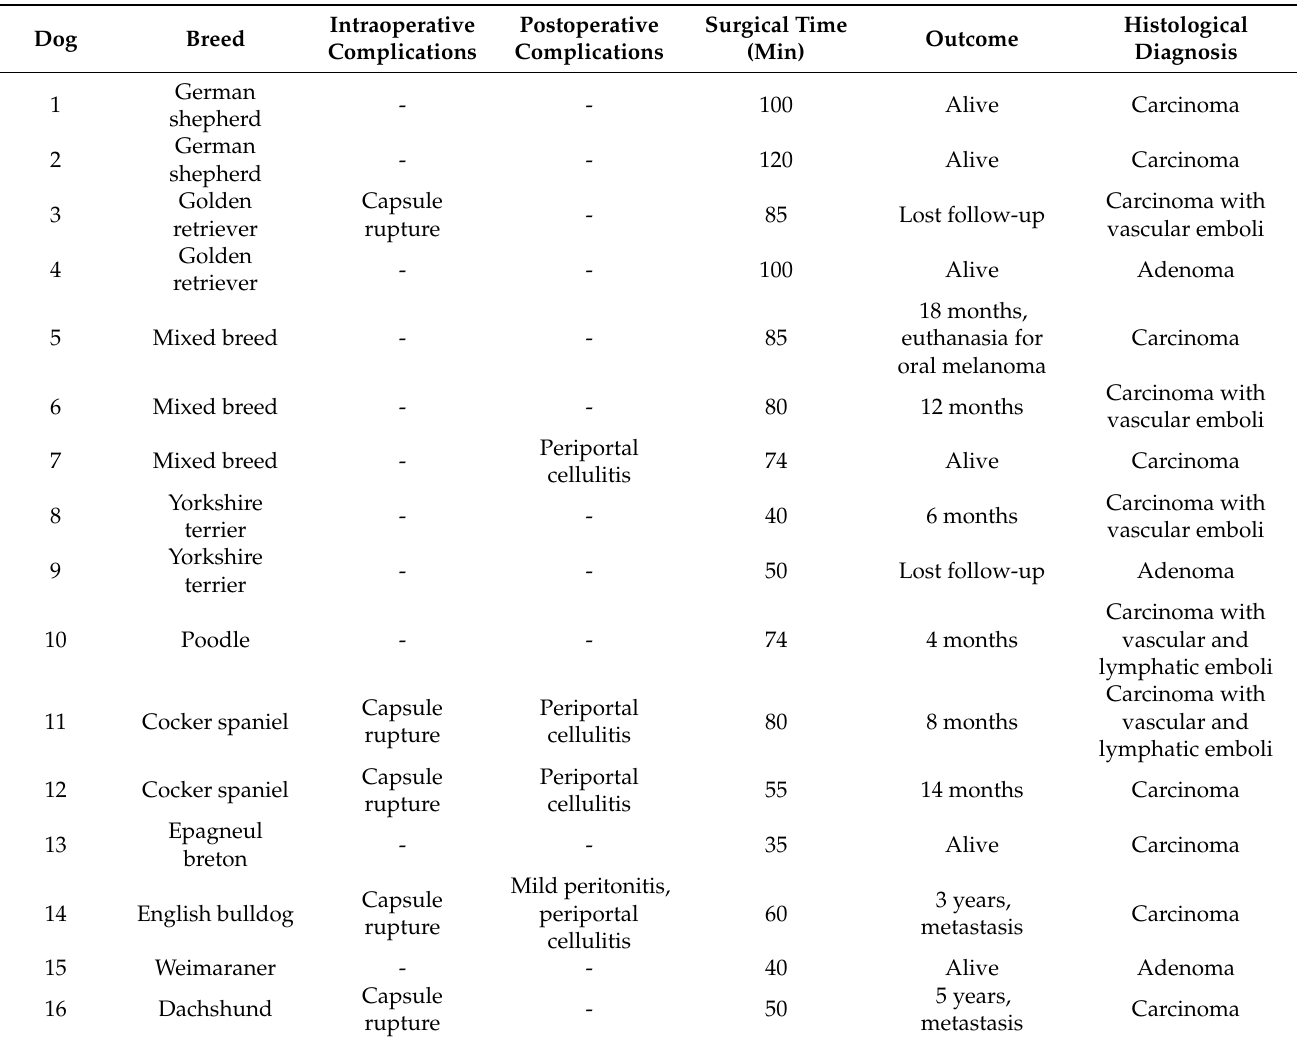
Table 2. In the table are reported data about intraoperative and postoperative complications, surgical time, outcome, and histological diagnosis collected in the study